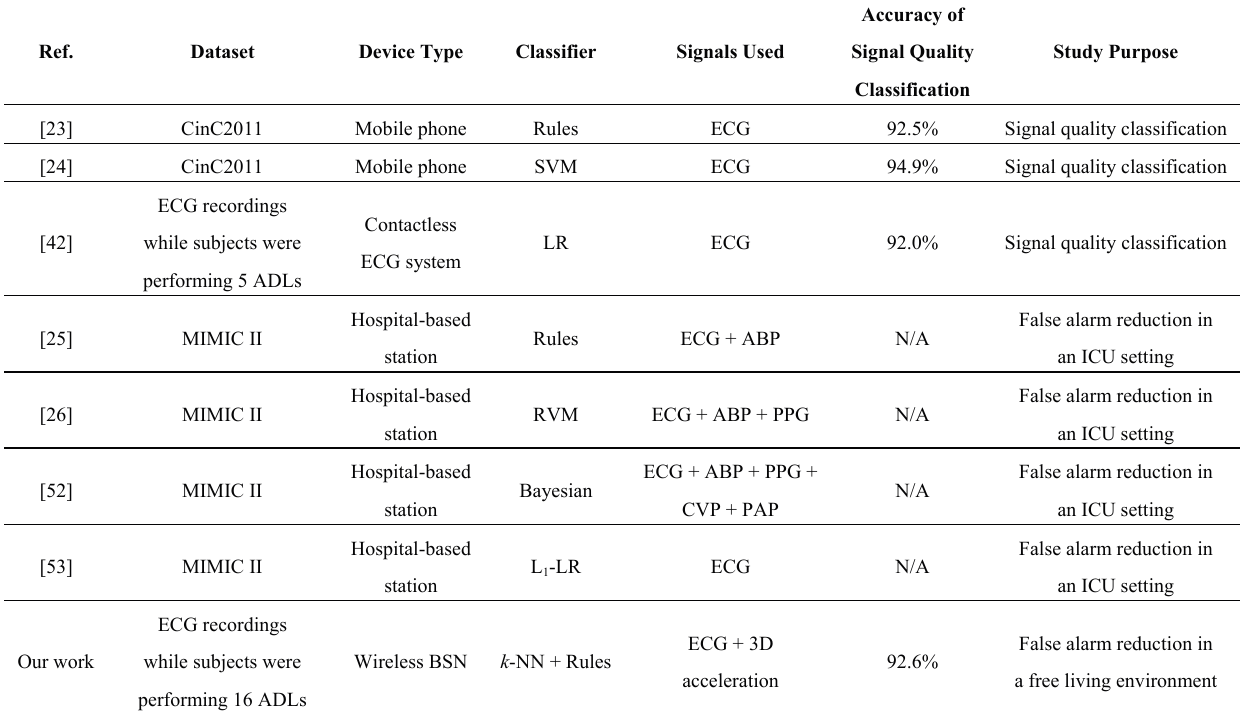
Table 14. Comparison with related